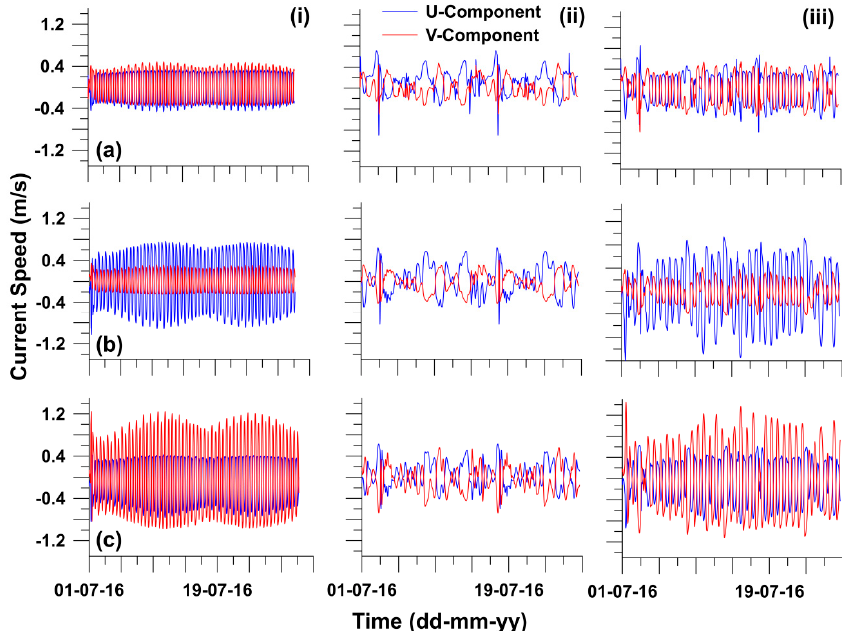
Figure 8. Time series of currents in SW-monsoon forced with (column-wise): ( i ) only tide, ( ii ) only wind, and ( iii ) tide and wind; for (row-wise) ( a ) northern Gulf, ( b ) eastern Gulf, and ( c ) western Gulf.